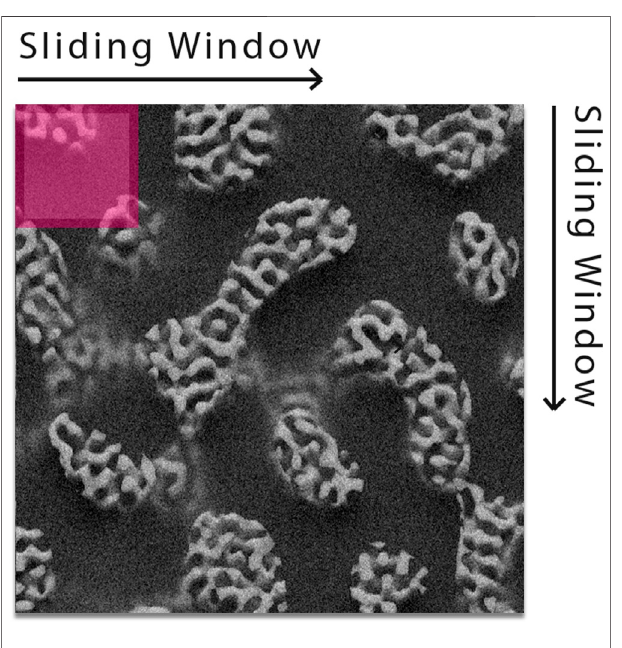
FIGURE 6 | Sliding window method.